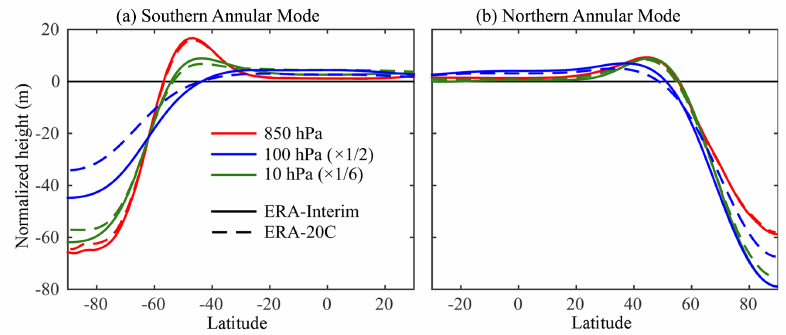
Figure 2. Example annular mode patterns, computed over the period 1981–2010 from ERA-Interim (solid lines) and ERA-20C (dashed lines) at three select levels. As the geopotential height anomalies increase at higher levels, the amplitude of the 100 and 10hPa patterns has been divided by 2 and 6, respectively. The 1000hPa patterns are nearly identical to the 850hPa patterns; we show the latter to minimize the need for extrapolation in the austral